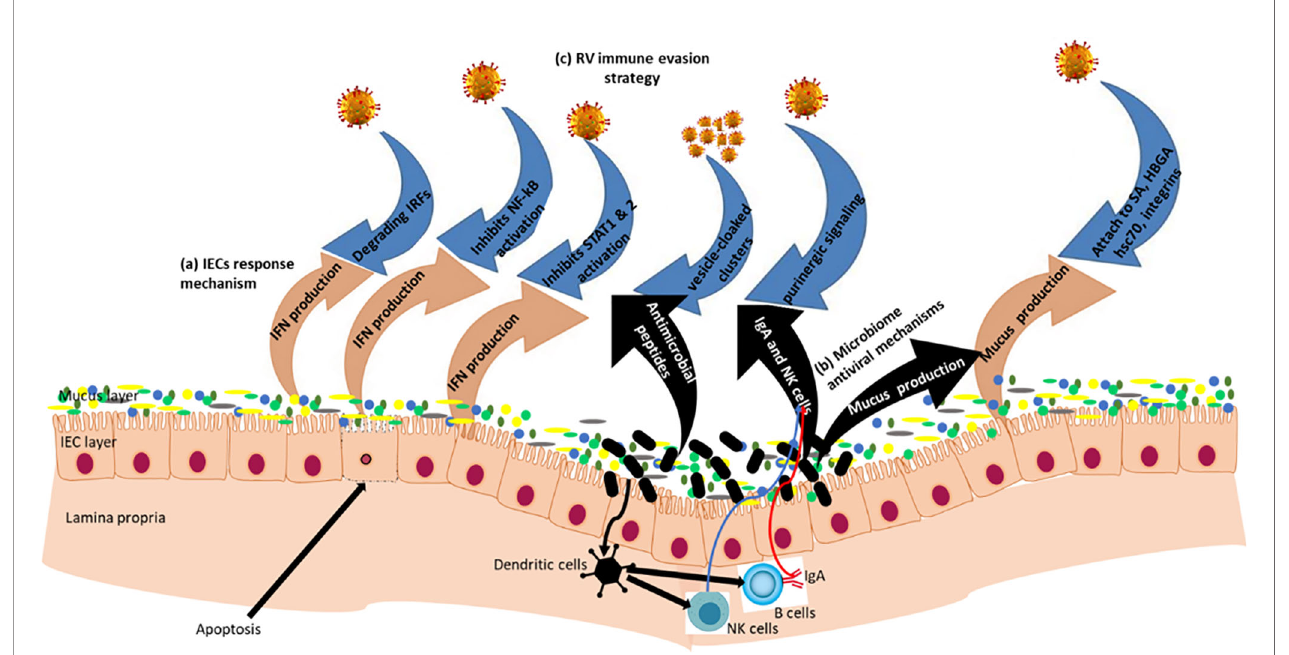
FIGURE 3 | Rotavirus-IECs-gut microbiome Interactions: Gut epithelial surface covered by mucus layer containing glycoproteins (mucins) which provide a physical barrier between viruses and IECs. Mucin production is in fl uenced by the gut microbiome composition of which some of the microbiota have antiviral properties. (a) In the IECs, RVs are recognized by the pattern recognition receptors (PRRs) and initiate mechanisms that induce IFN responses. (b) Bene fi cial microbiota inhibit viral attachment to host epithelial cells; they produce antimicrobial compounds which have antiviral effects; and also modulate innate and adaptive immune systems. (c) RV immune evasion strategy via blocking IFN responses through degradation of IFN Regulatory Factors (IRFs) and inhibition of nuclear accumulation of NF − k B, STAT1 and STAT2. RVs form pools of virions cloaked in extracellular vesicles to enhance multiplicity of infection, and RVs also utilize intercellular calcium waves and purinergic signaling to amplify intestinal